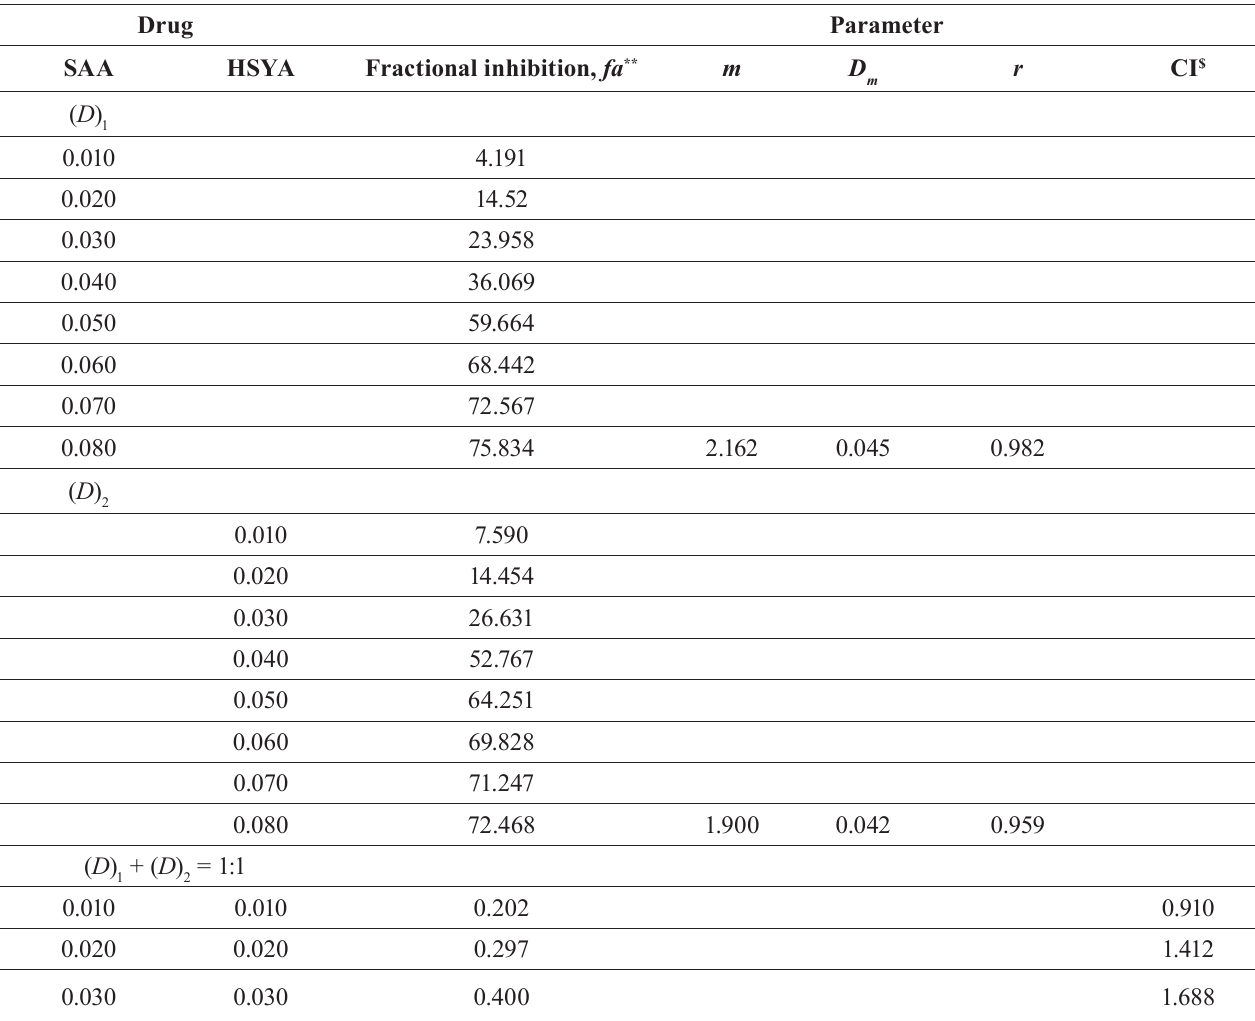
TABLE IV - Example of experimental design and dose-effect relationships of SAA and HSYA, and their two-drug combinations on growth inhibition of rat brain microvascular endothelial cells in vitro * Drug Parameter SAA HSYA Fractional inhibition, fa ** m D